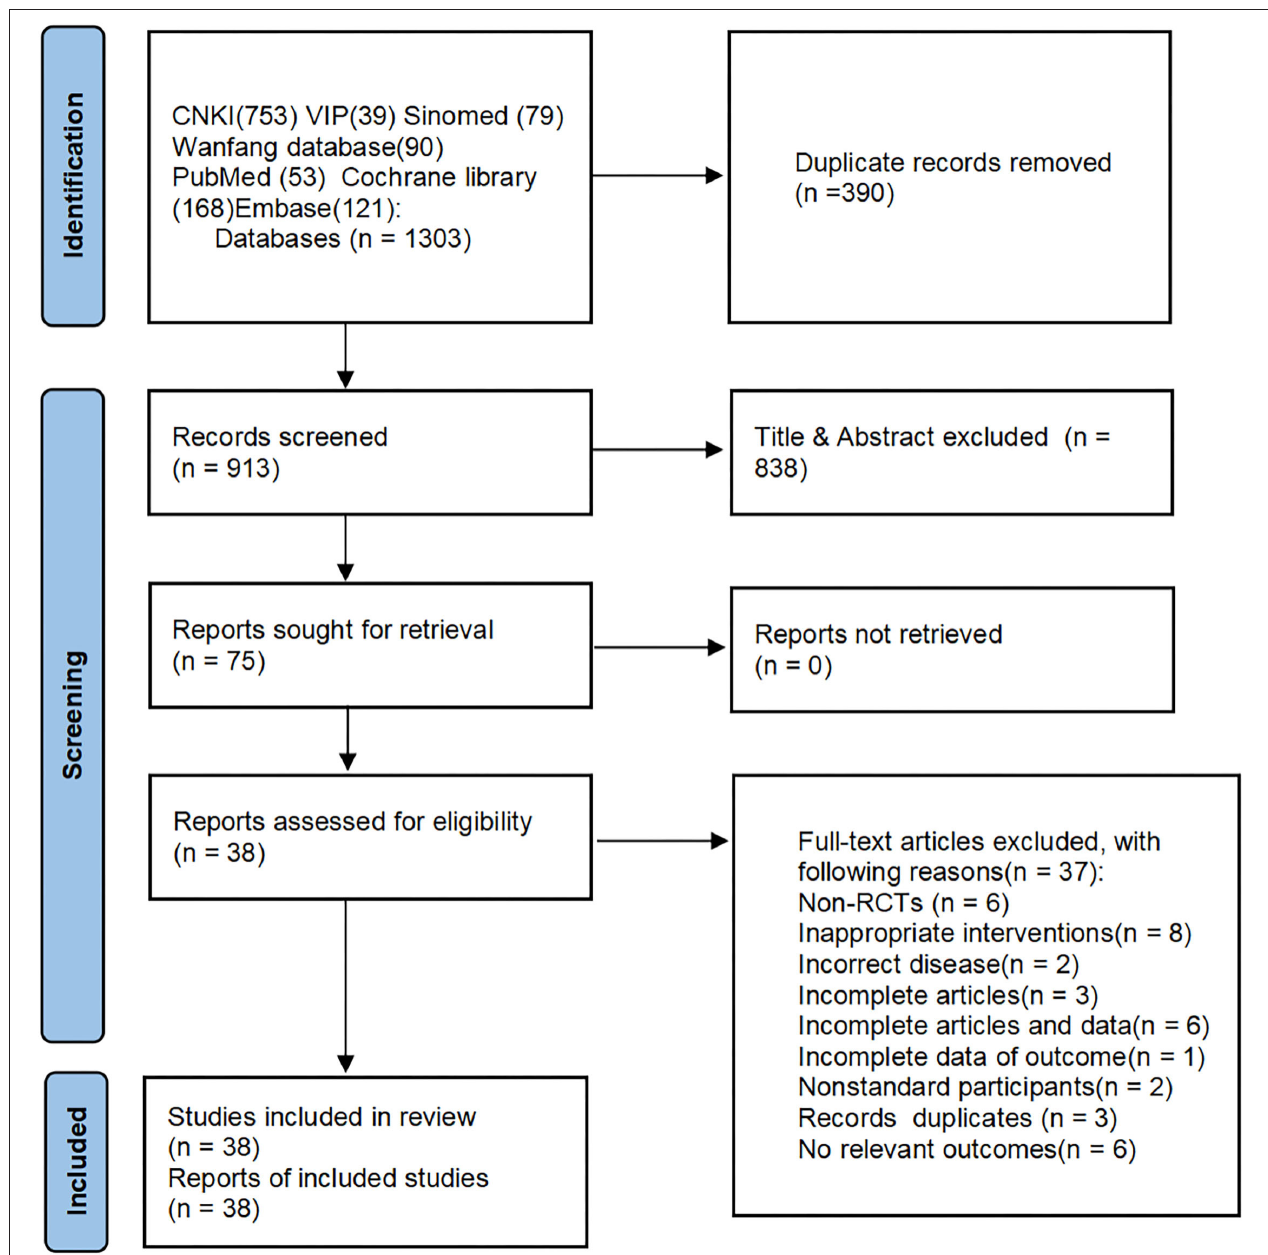
FIGURE 1 | The flow chart of study searching and